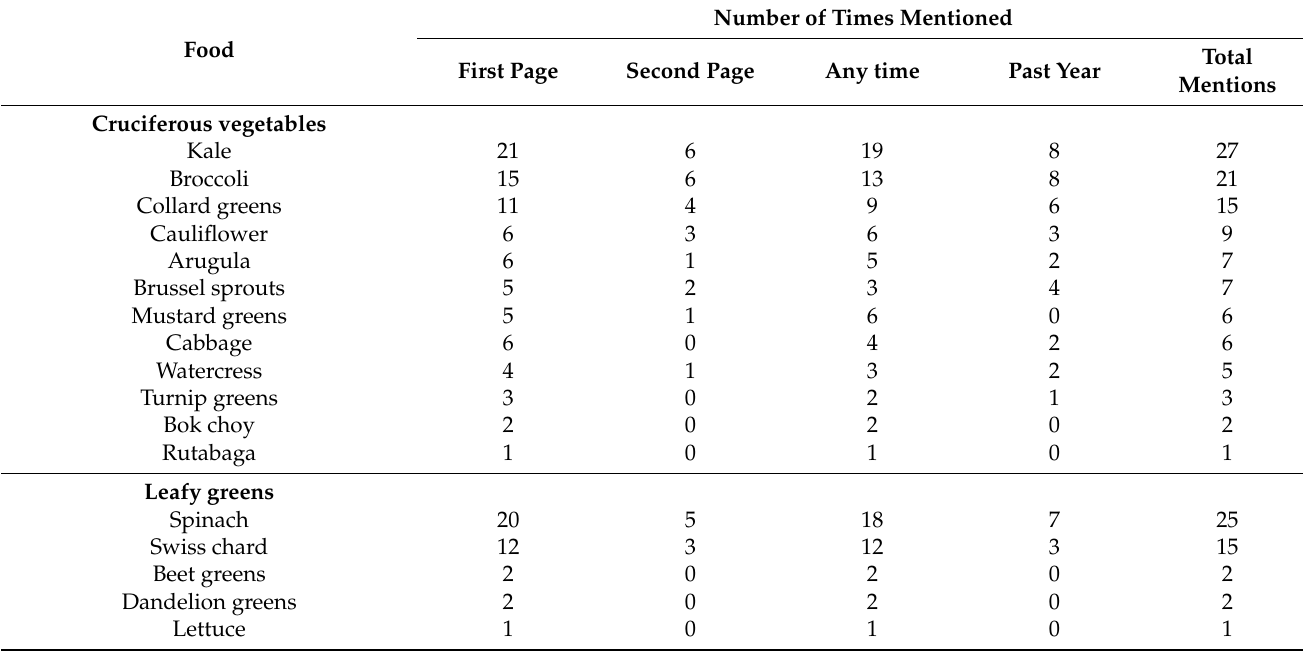
Table 2. Classification of cruciferous vegetables and leafy greens by the number of times that were mentioned on selected web pages.